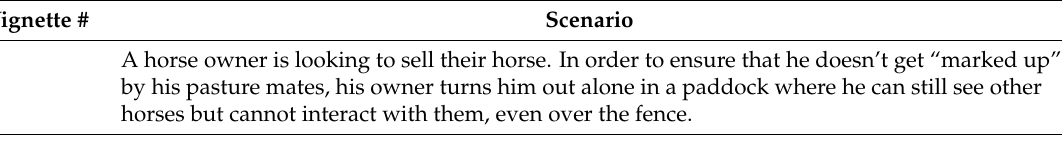
Table A1. Vignettes viewed by survey respondents ( n =